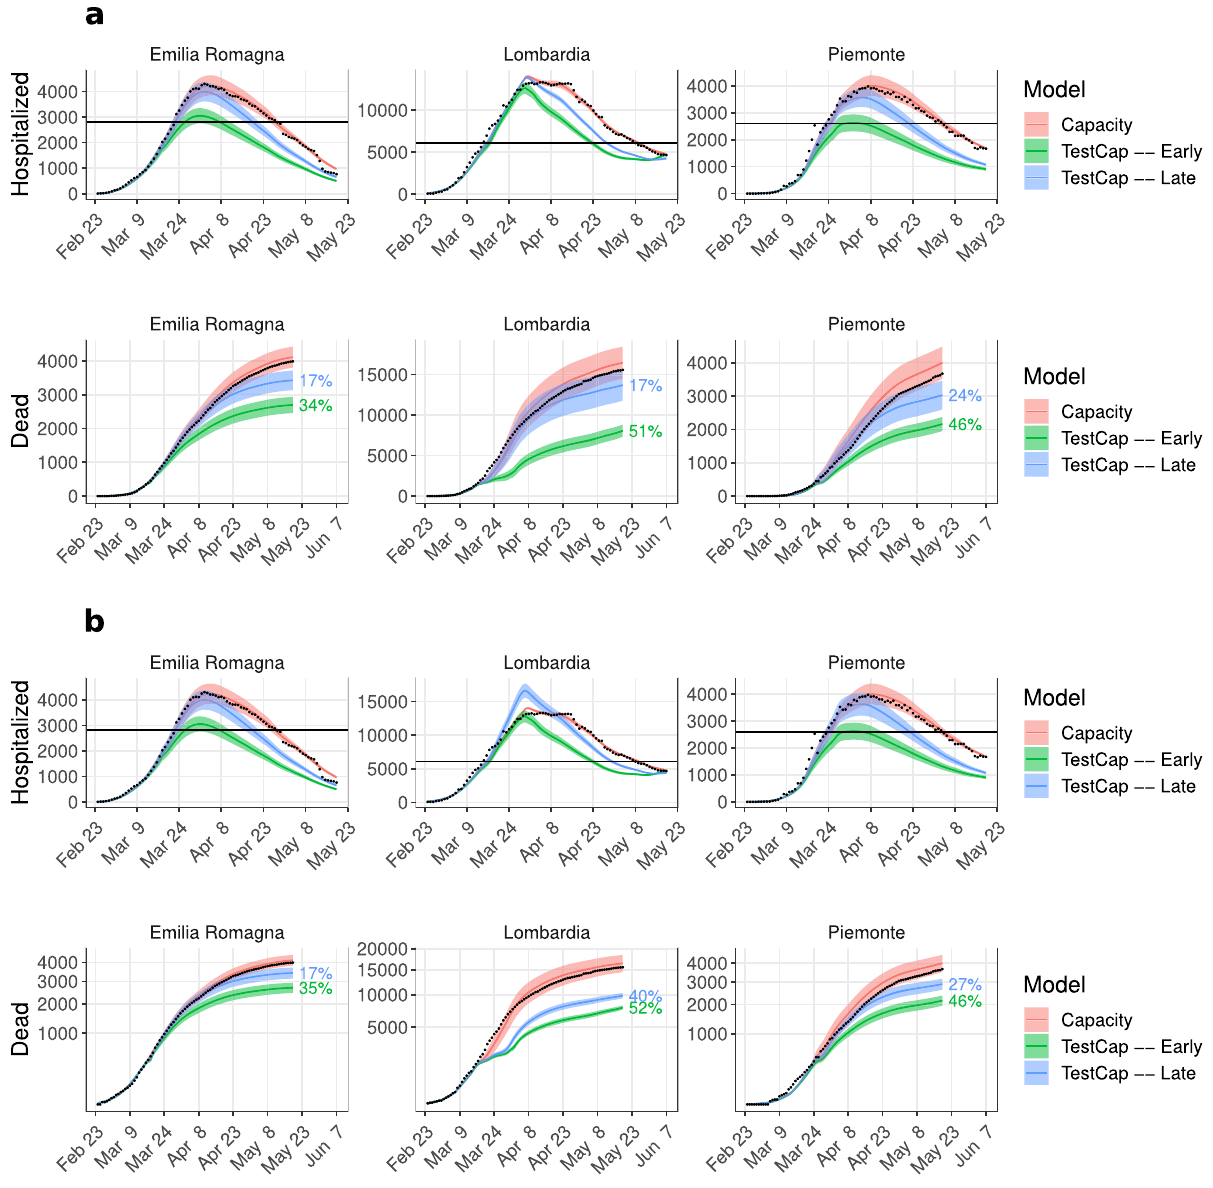
Fig. 7 A strategy of early TI and extending hospital capacity combined. Simulation results of the TestCap Model . a Linear increase of hospital and ICU capacities (scenarios 1 and 2) and b maximum capacities from the beginning (scenarios 3 and 4) with early (green) or late testing. Statistics were performed by fi tting the data with 100 perturbed parameter sets (see Methods). The line and the shaded region represent the mean and standard deviation, respectively. The hospitalized population is the sum of hospital and ICU patients. The percentage indicates the mean reduction in hospitalized peak and death number with respect to the mean of the Capacity Model . Black dots: data; black horizontal line: capacity (hospital + Intensive Care Unit) before the